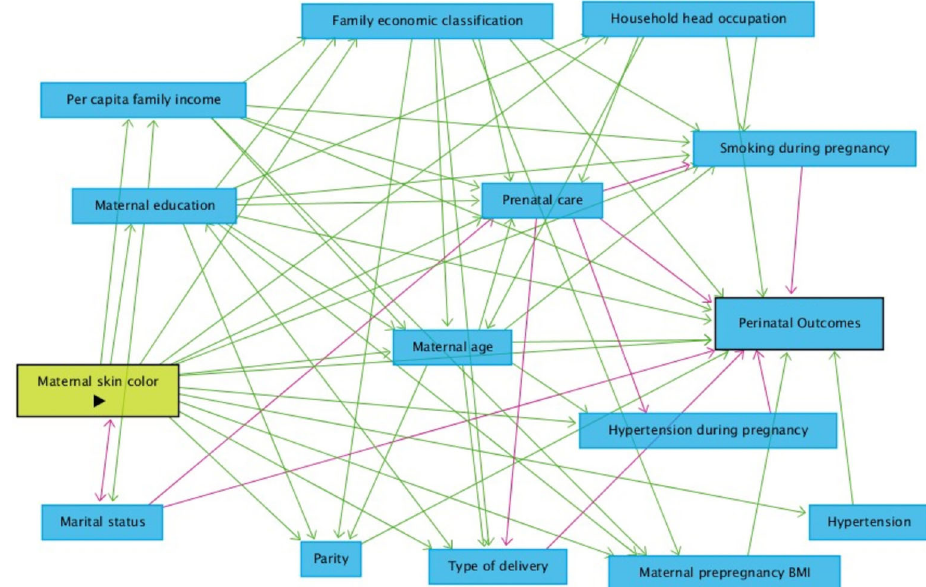
Figure 1. Directed acyclic graph of the effect of maternal skin color on perinatal outcomes. The outlined green rectangle represents the exposure and the outlined blue rectangle represents the outcome. The remaining blue rectangles represent the ancestors of the outcome. The green arrows represent the causal path and the pink arrows represent the biasing path. BMI: body mass